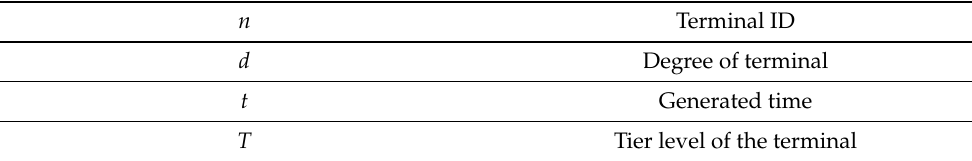
Table 2. HELLO message